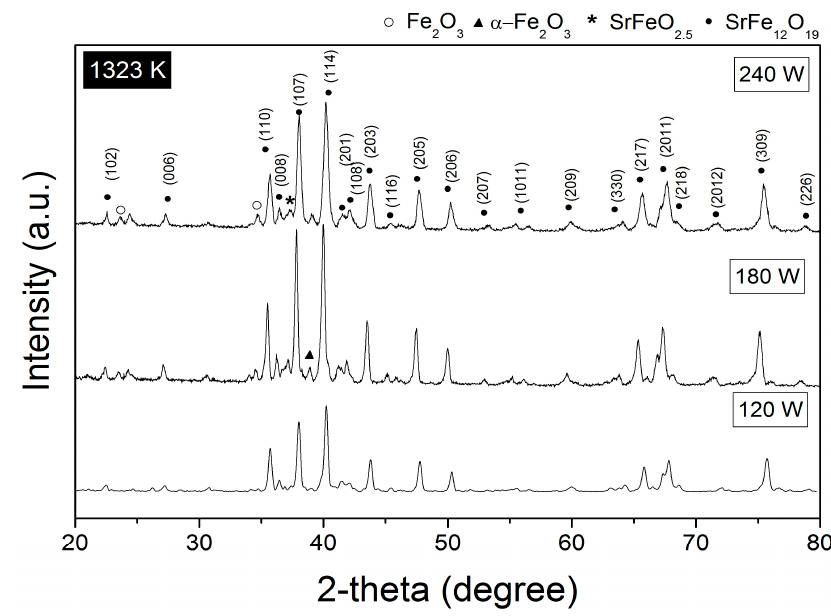
Figure 5. XRD patterns of powders after applying different SOP for 3 h and thermal treatedment at 1323 K.